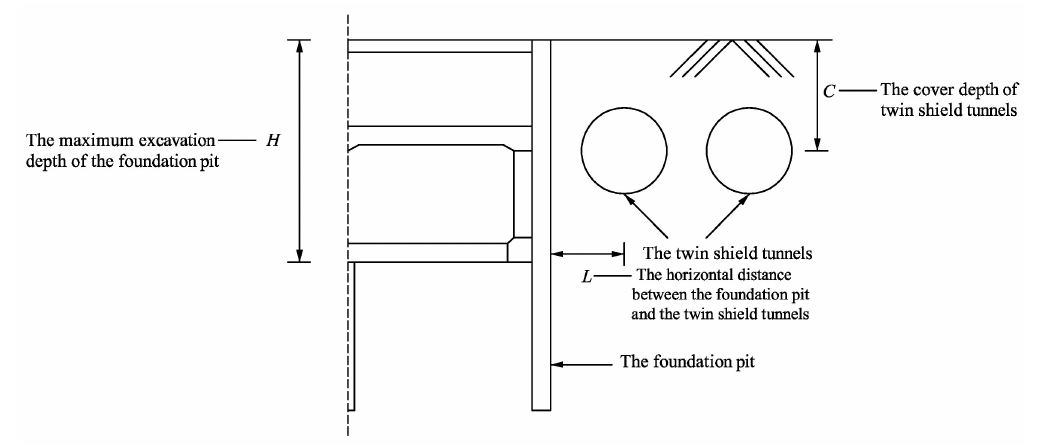
Figure 5. Schematic diagram of relative position between the foundation pit and the twin shield tunnels.